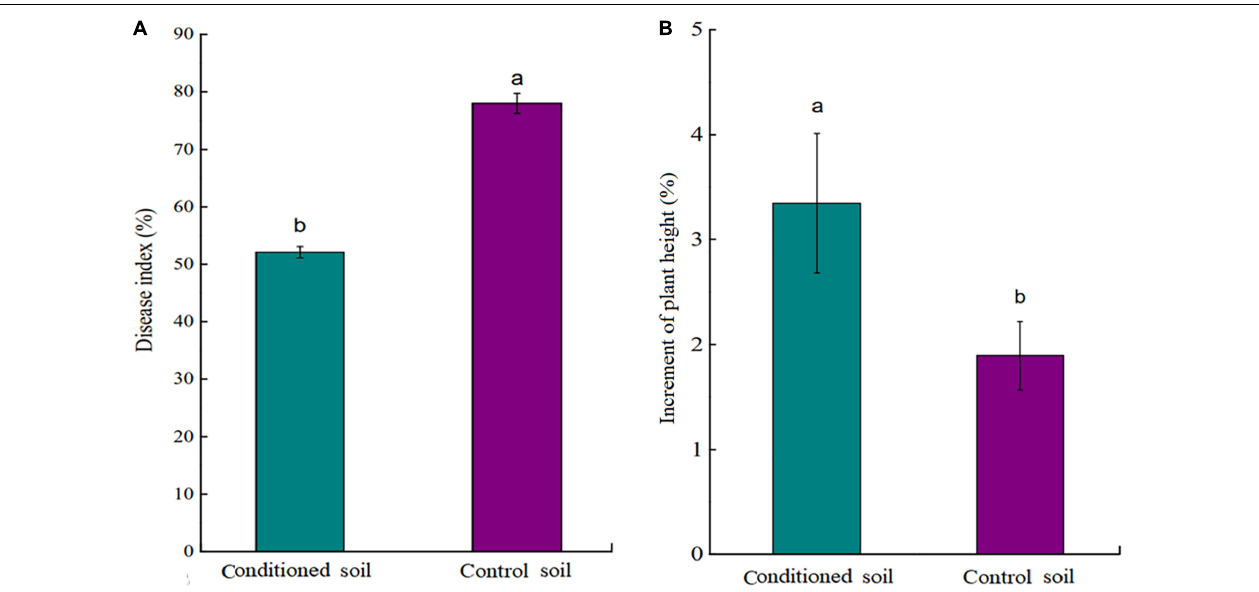
FIGURE 2 | (A) Disease index (DI) of tea seedlings grown in conditioned or control soil and challenged with Ps. camelliae-sinensis for 7 days. (B) Plant height of tea seedlings grown in conditioned or control soil for 30 days. a and b represent statistically significant differences between treatments as determined by Student’s t -test ( p < 0.05). Data are means ± SEs ( n = 6).